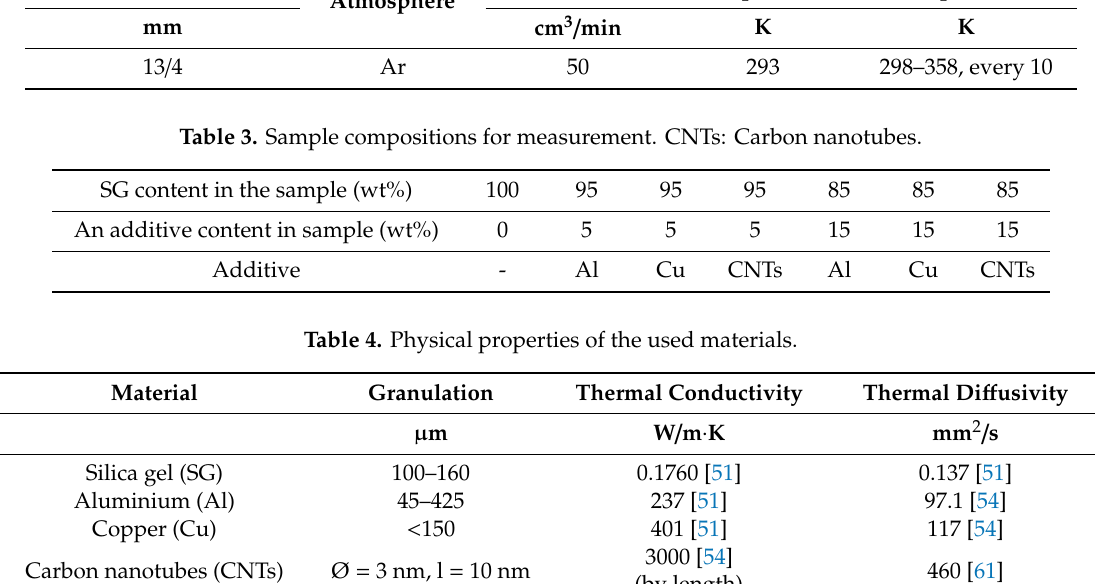
Table 4. Physical properties of the used materials.